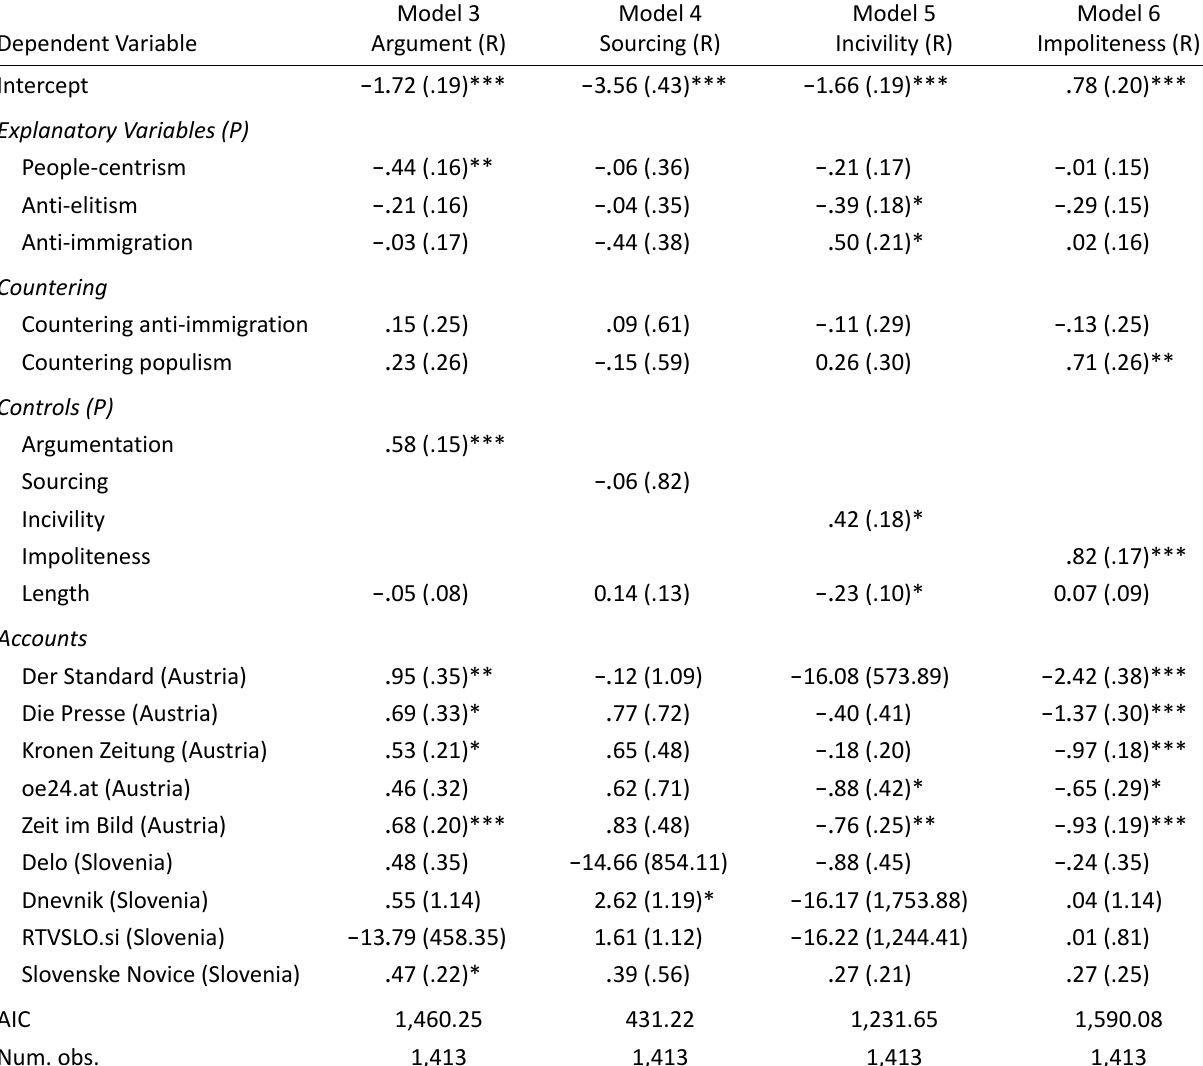
Table 2. Logistic regression results.